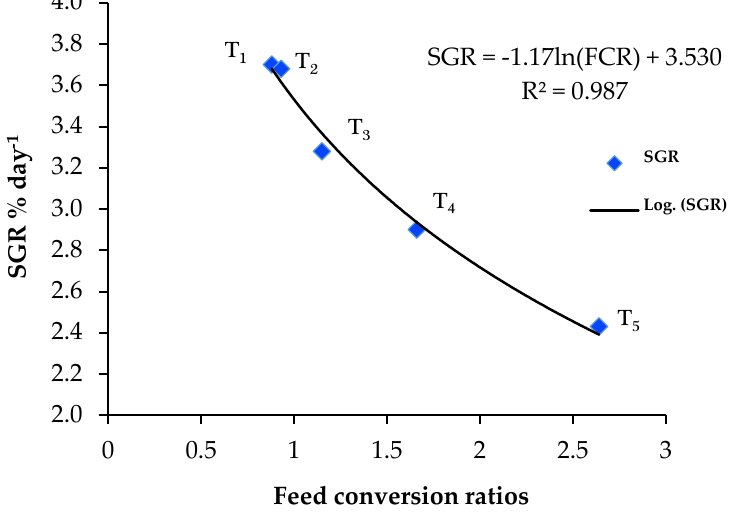
Figure 1. Relationship of SGR and FCR of Thai silver barb B. gonionotus fed different percentages of A. pinnata and commercial fish feed in five treatments after rearing for 56 days.